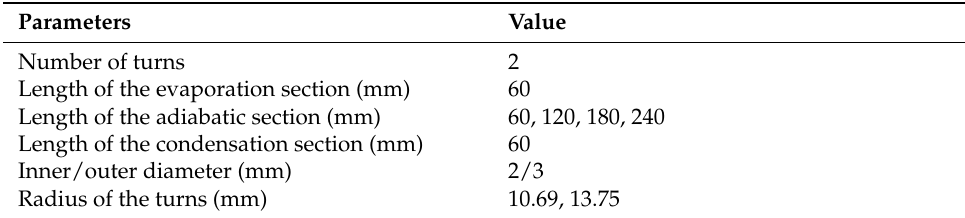
Table 2. The geometric parameters of the PHP. Parameters Value Number of turns 2 Length of the evaporation section (mm) 60 Length of the adiabatic section (mm) 60, 120, 180, 240 Length of the condensation section (mm) 60 Inner/outer diameter (mm) 2/3 Radius of the turns (mm) 10.69,